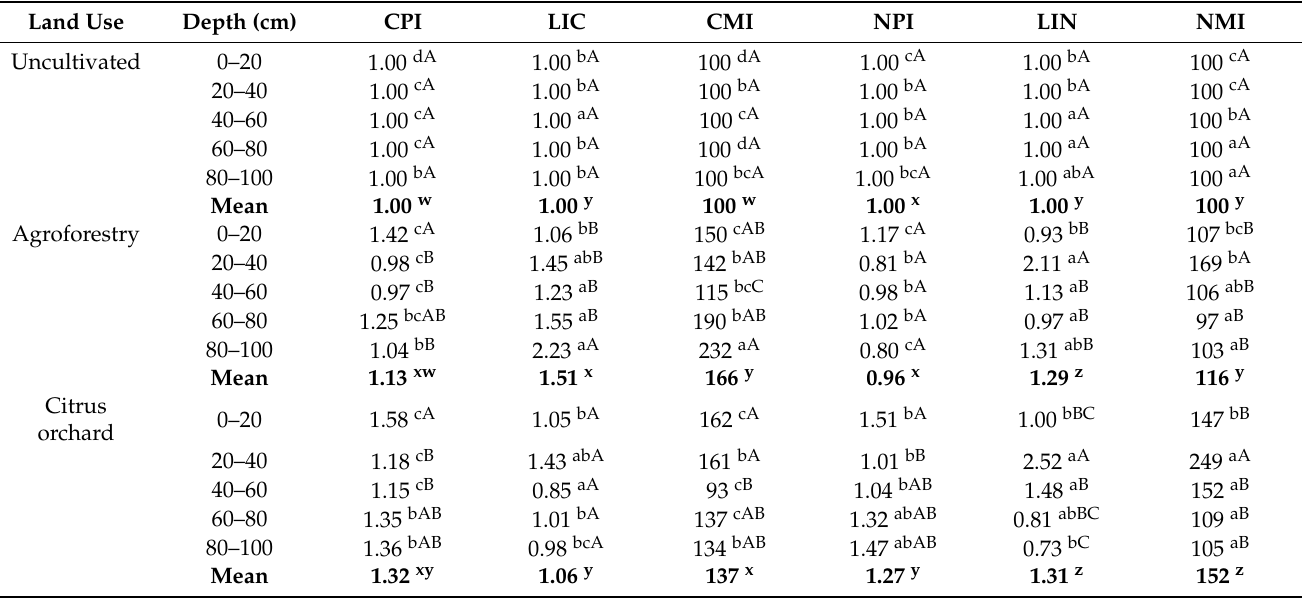
Table 7. In a hot, arid environment, depth-wise distribution of carbon and nitrogen management indices as influenced by different land use